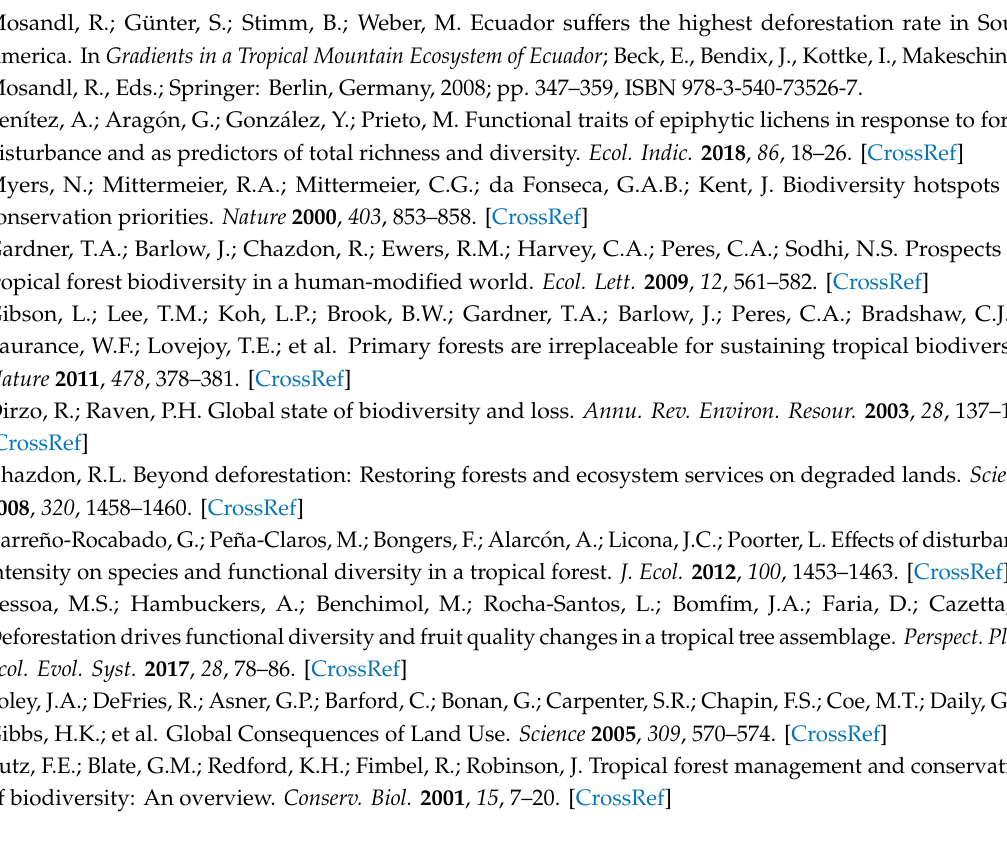
Figure S1: Plots distribution in two forests types, the location of plot K that served as a control is shown in addition to the Q2 plots, Table S2: PCT´s list and individuals released and control, Table S3: Individuals by species removed and percentage with respect to the total of individuals inventoried in primary montane forest of